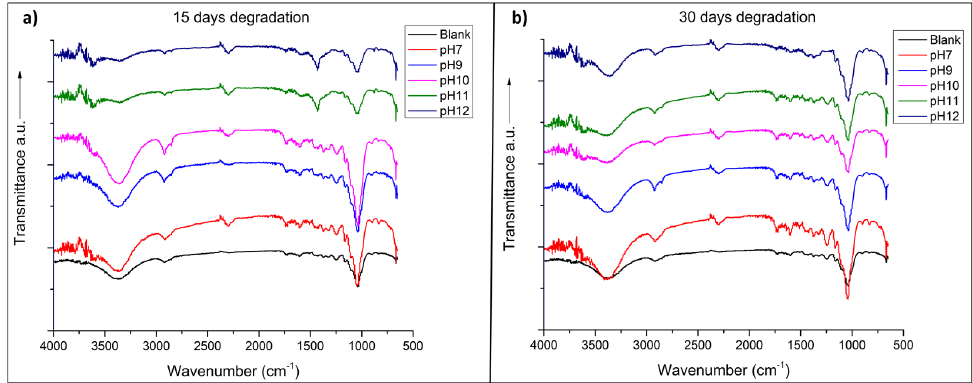
Figure 2. FTIR (Fourier transform infrared spectroscopy) spectra of the samples from the bagasse (blank) and subjected to different pH values: ( a ) 15 days of degradation and ( b ) 30 days of degradation.